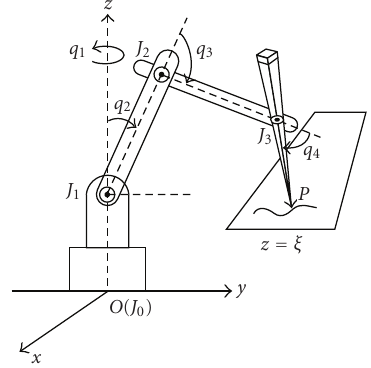
Figure 4: A hand-writing robot with four DOFs whose endpoint P ( = ( x , y )) is constrained on a plane z =